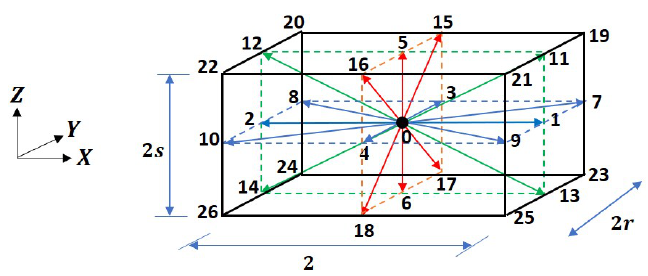
Figure 1. Three-dimensional, twenty seven particle velocity (D3Q27) cuboid